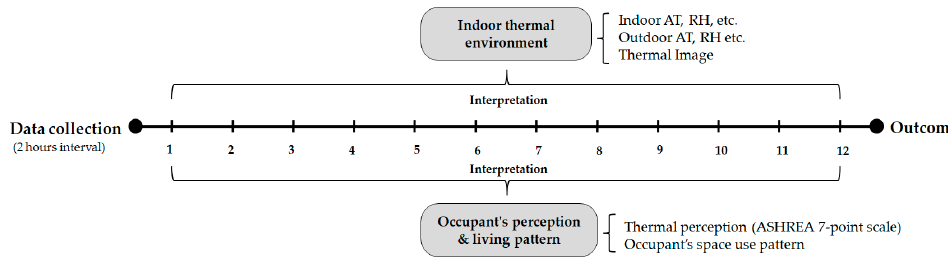
Figure 4. Data interpretation strategy.